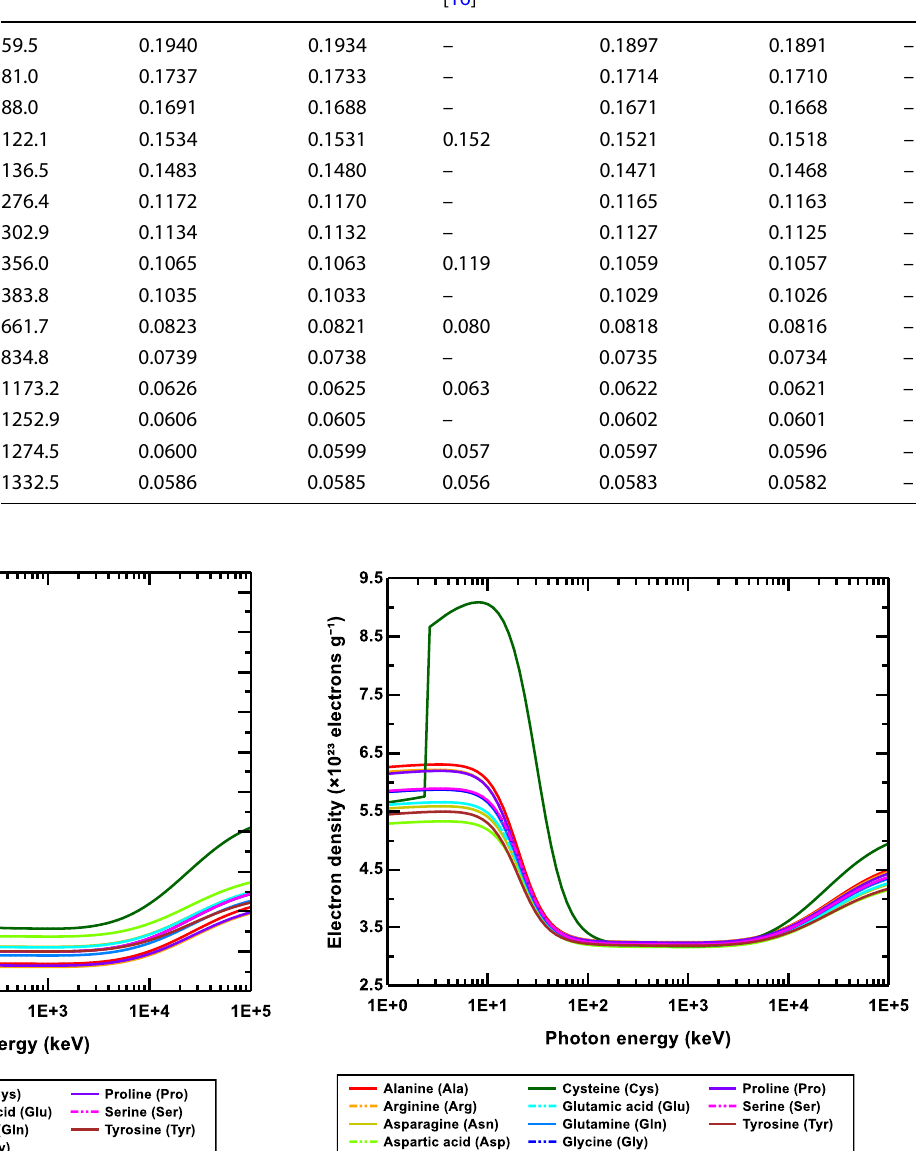
Table 5 Mass attenuation coefficients ( cm 2 g − 1 ) of serine and tyrosine